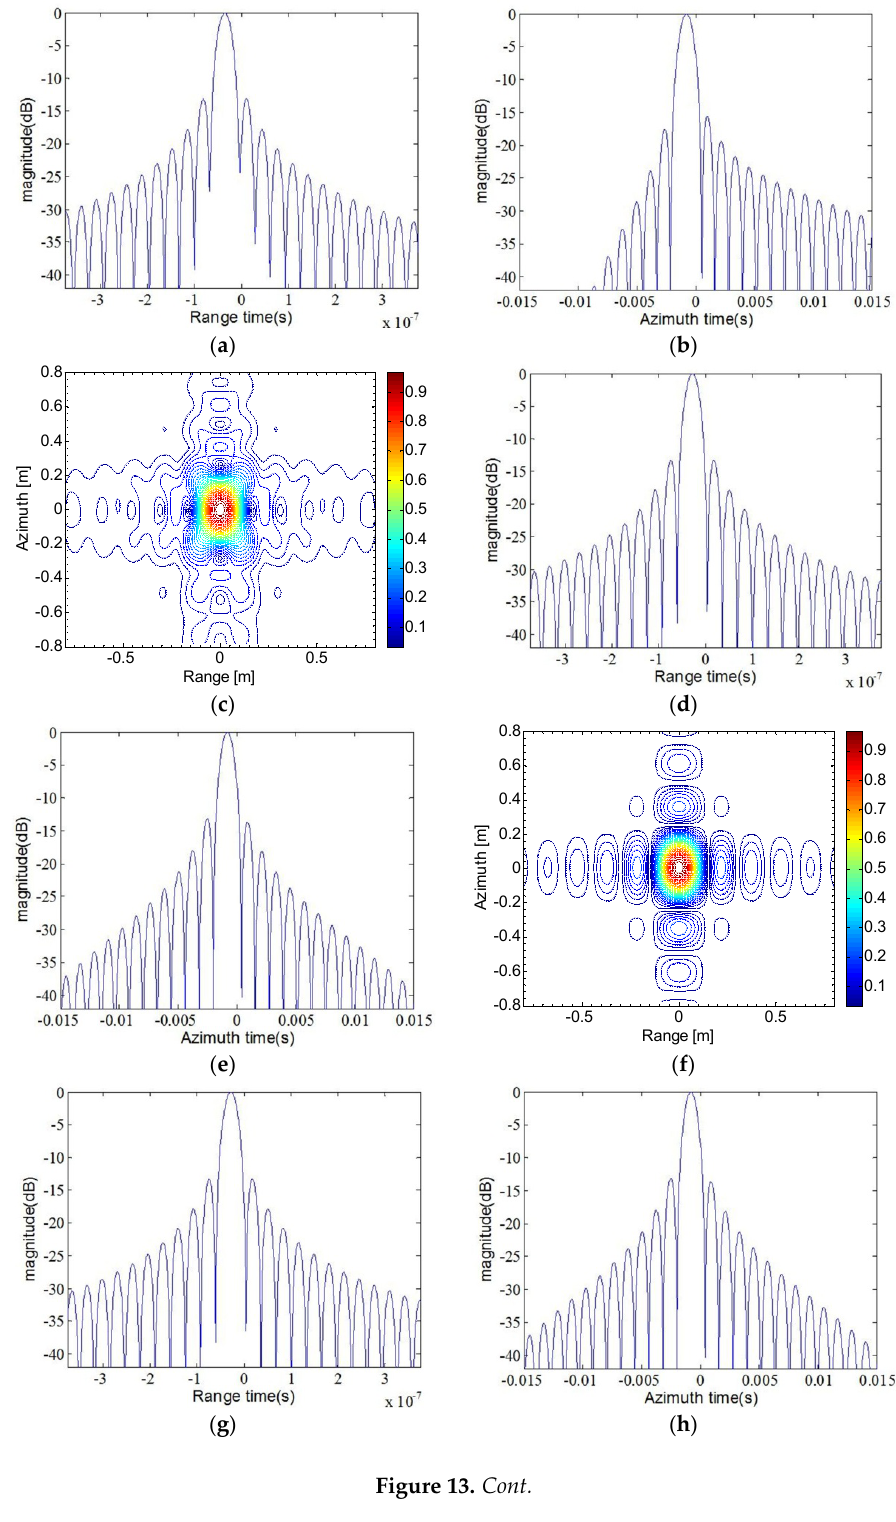
Figure 13. Cont. Figure 13.